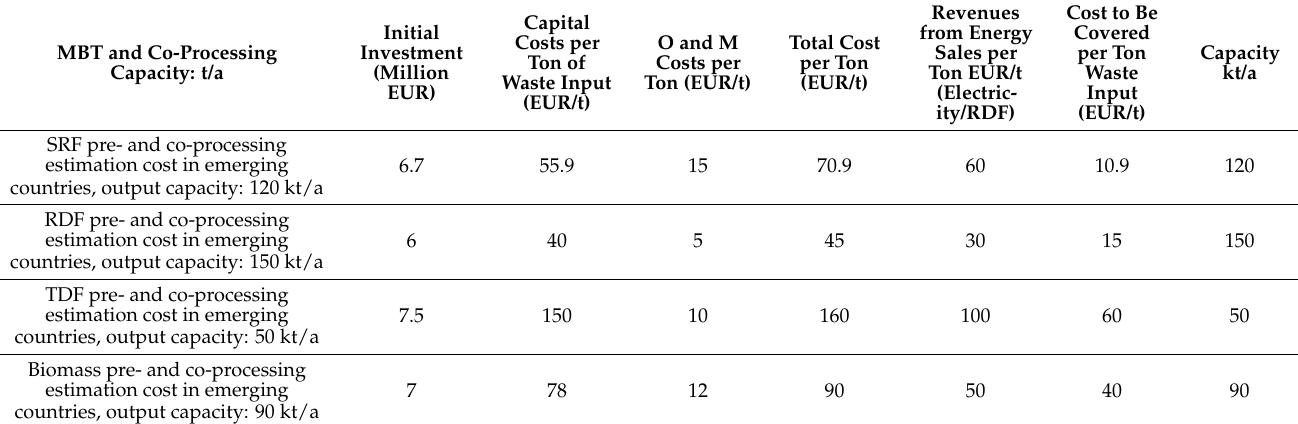
Table 6. Cost estimate of MBT with cement plant pre- and co-processing in Togo.